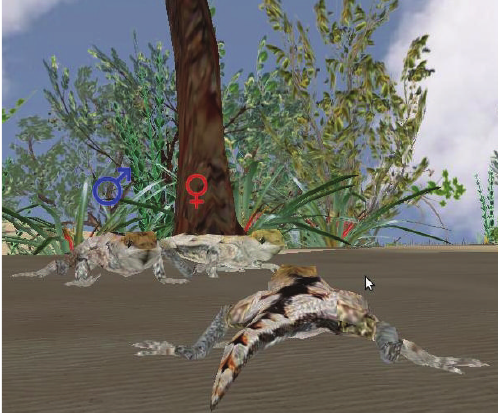
Figure 6: A predator (seriema) attacking the lizard.